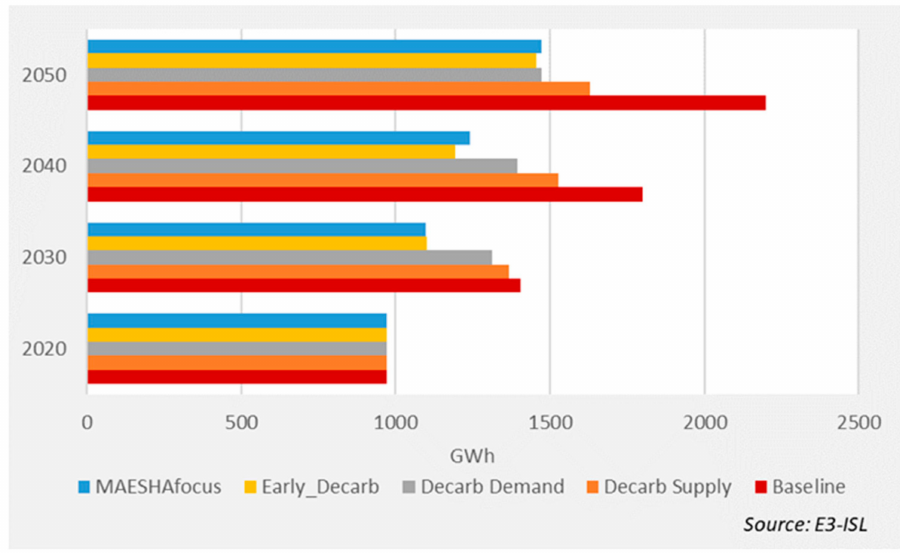
Figure 7. Evolution of final energy consumption in alternative scenarios.